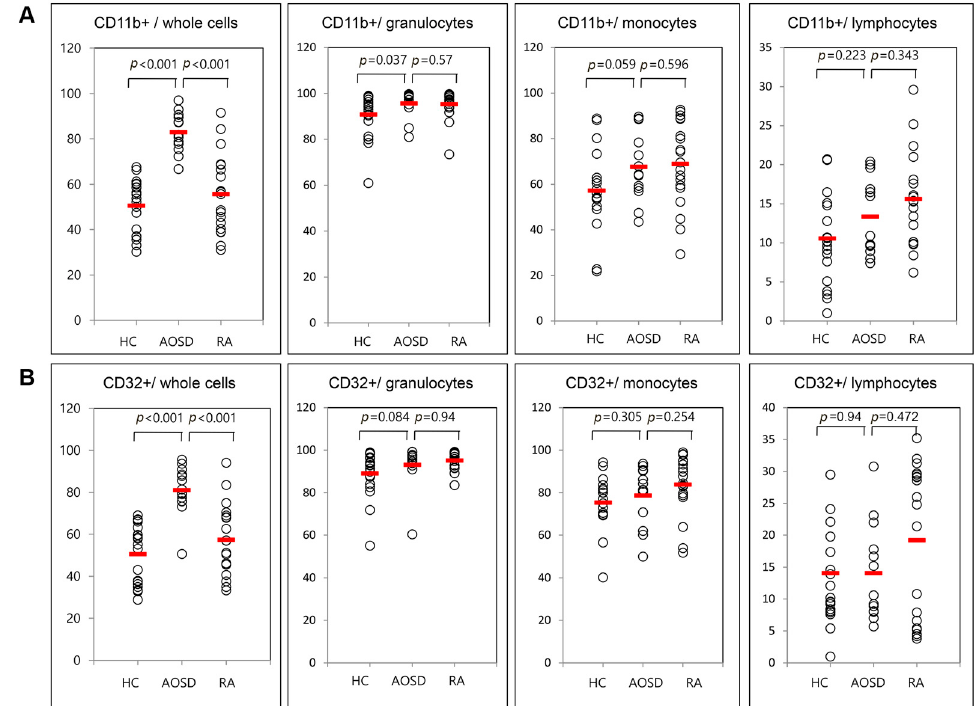
Figure 2. Flow cytometric results of the percentage of surface-stained cells presenting CD11b ( A ); and CD32 ( B ) in patients with adult-onset Still’s disease (AOSD), patients with rheumatoid arthritis (RA) and healthy controls (HC). Results were obtained from 13 patients with AOSD, 19 RA patients, and 19 HC. The horizontal line indicates the mean value for each group. The p -value was determined with the Mann–Whitney U -test.